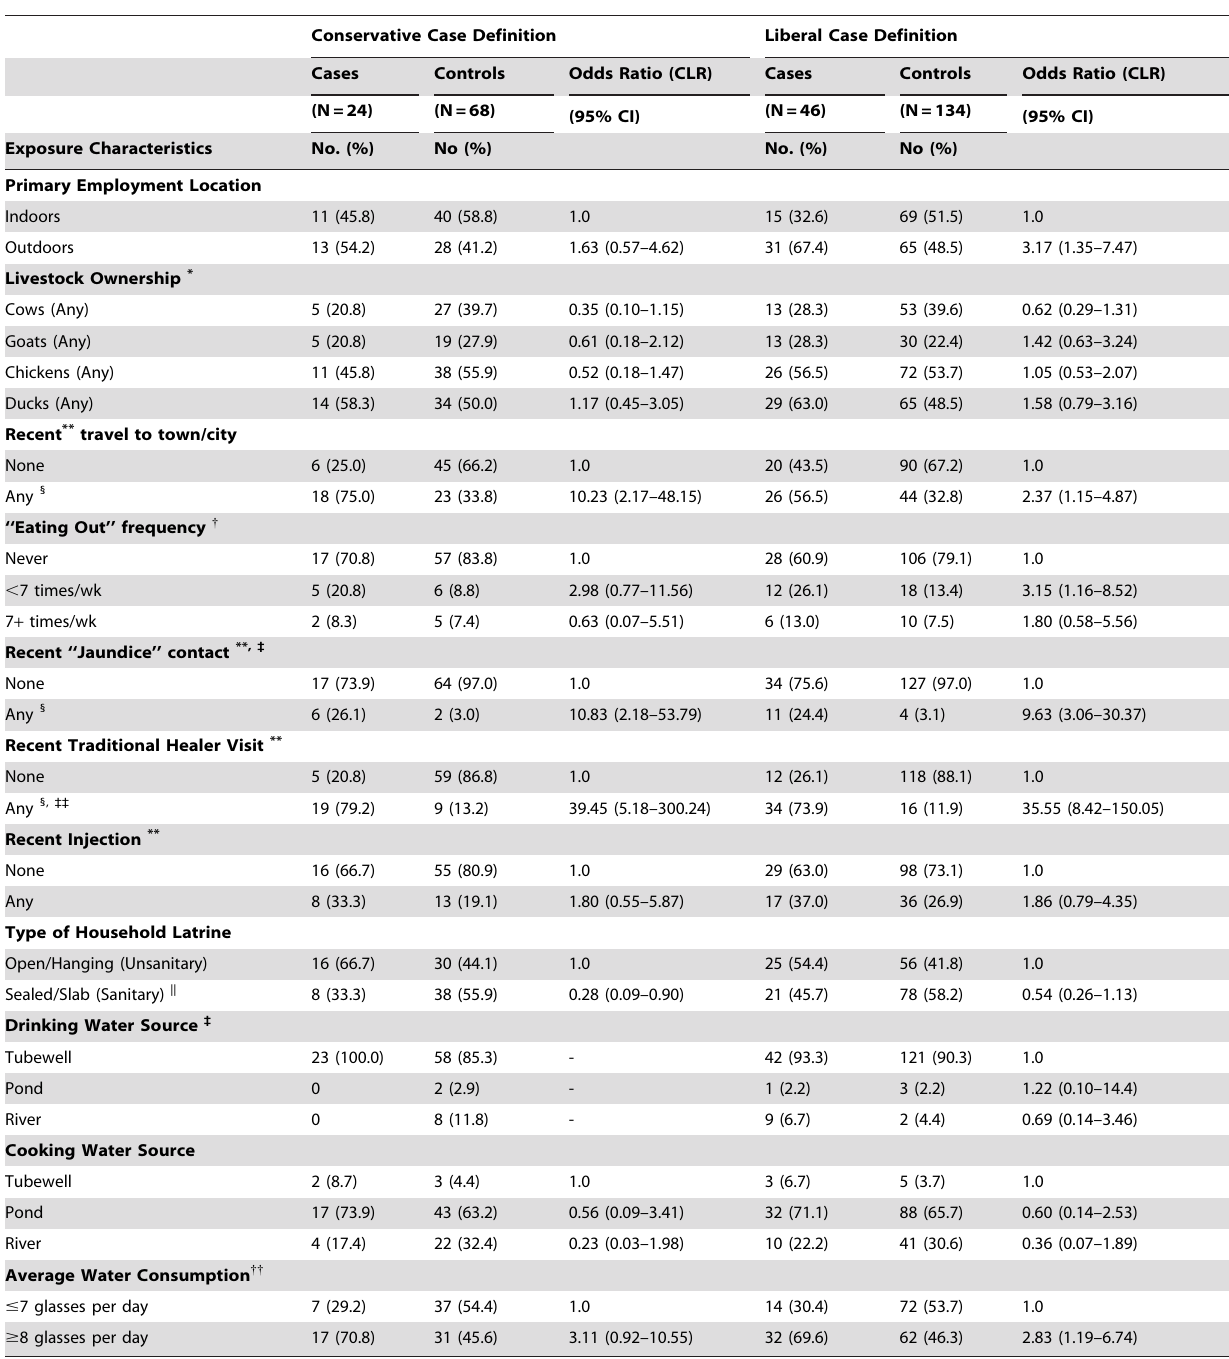
Table 4. Exposure characteristics of acute hepatitis E patients and age-matched